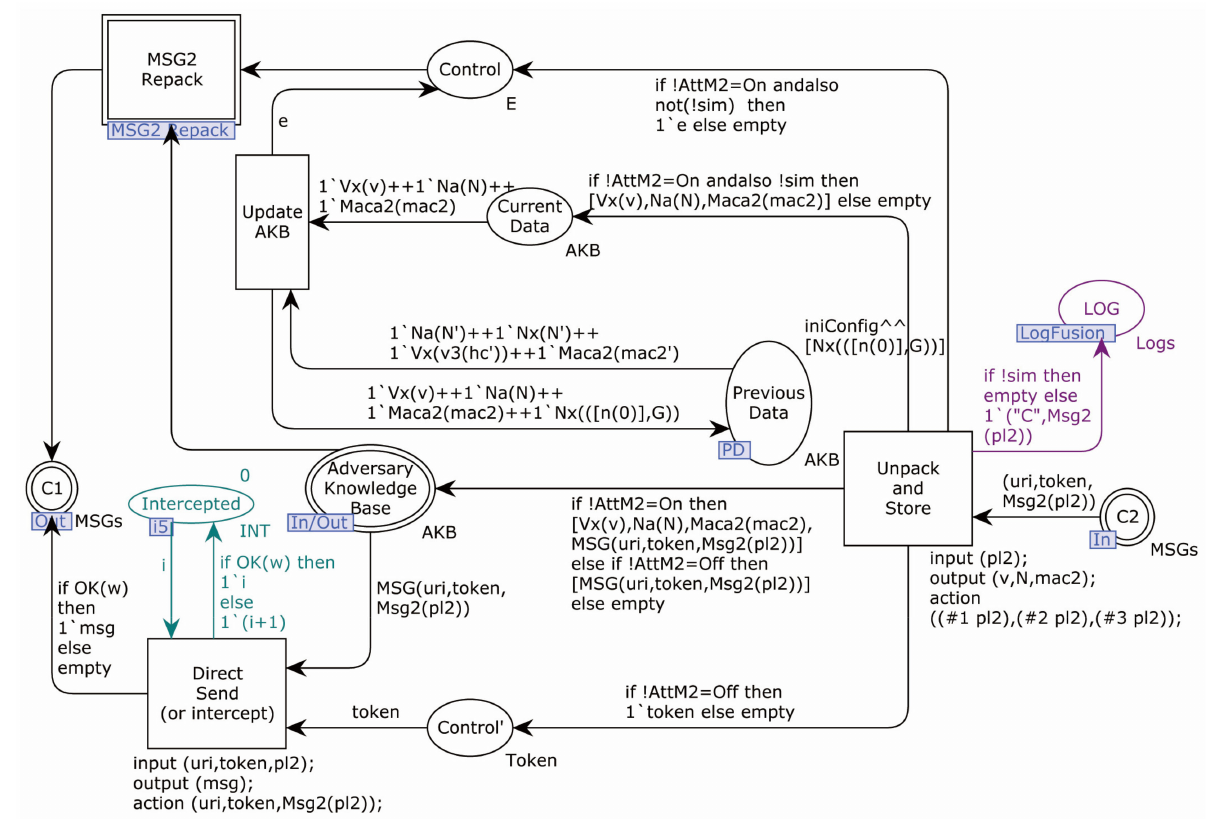
Figure 15. Adversary model sub-page